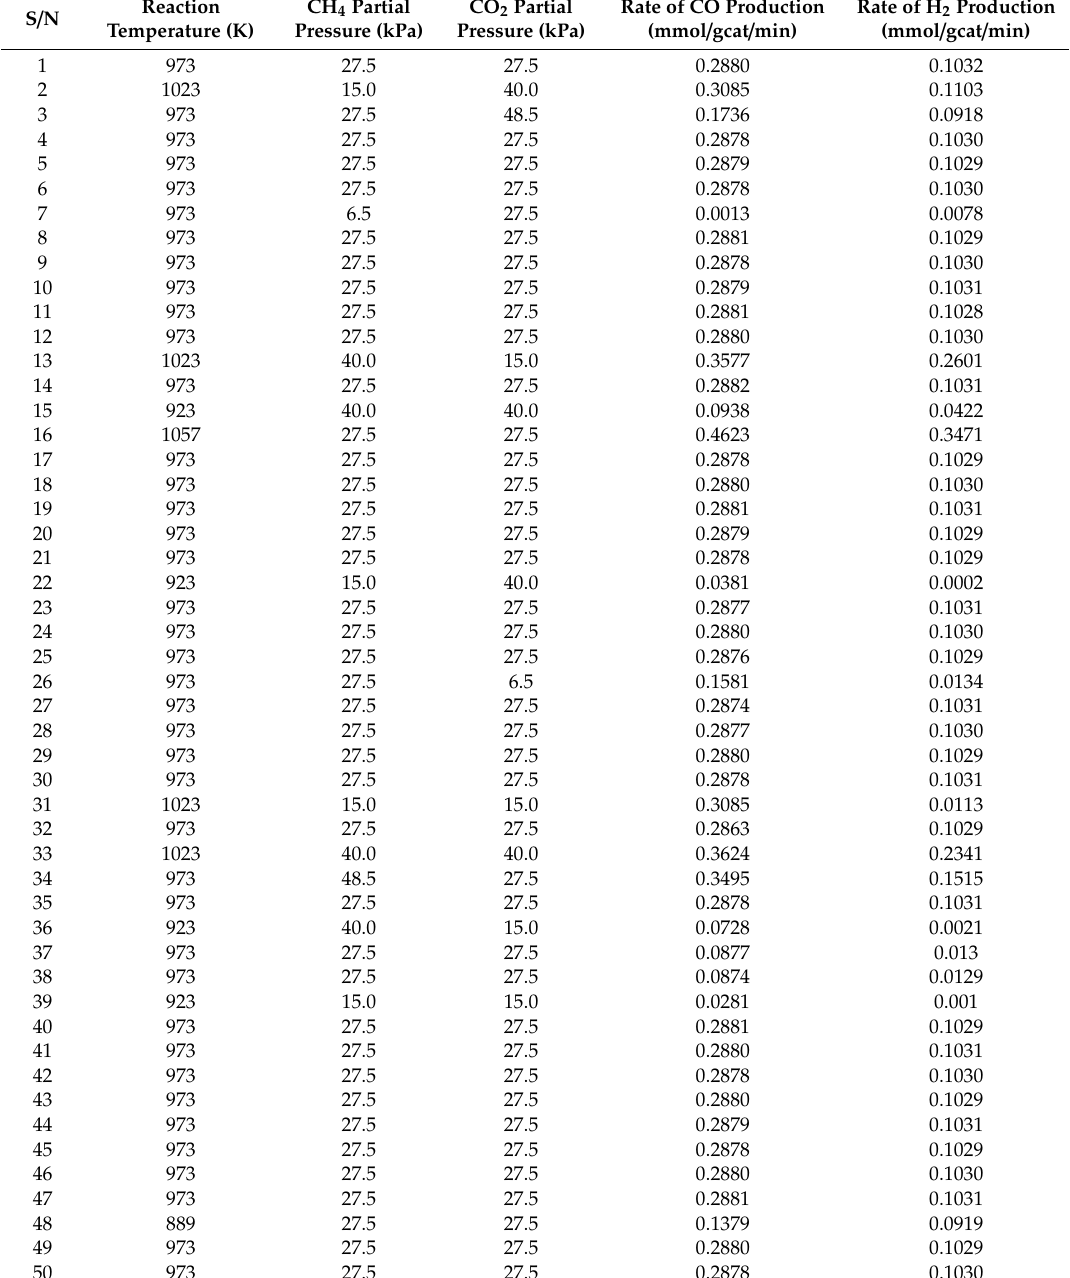
Table 1. Data obtained from central composite experimental design for artificial neural network (ANN)